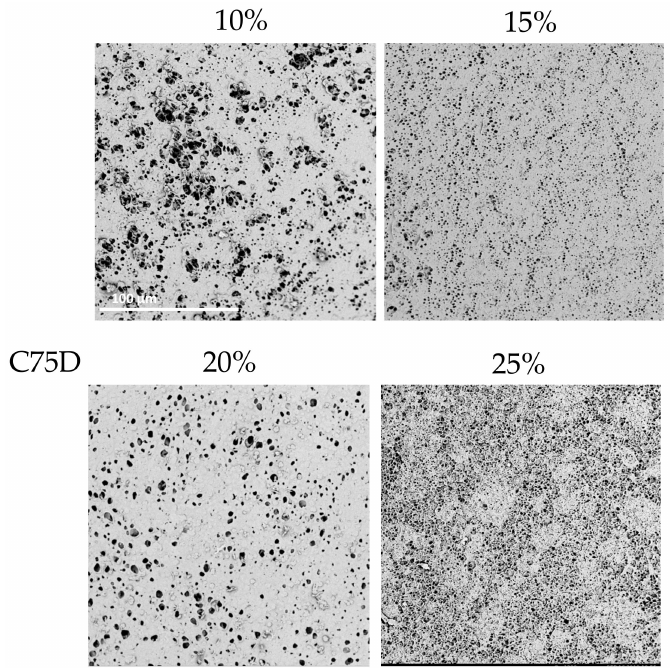
Figure 6. Morphology of internal surface of cylindrical scaffolds obtained from ChronoFlex C75D at different concentrations of polymer solution; scale bar: 100 µ